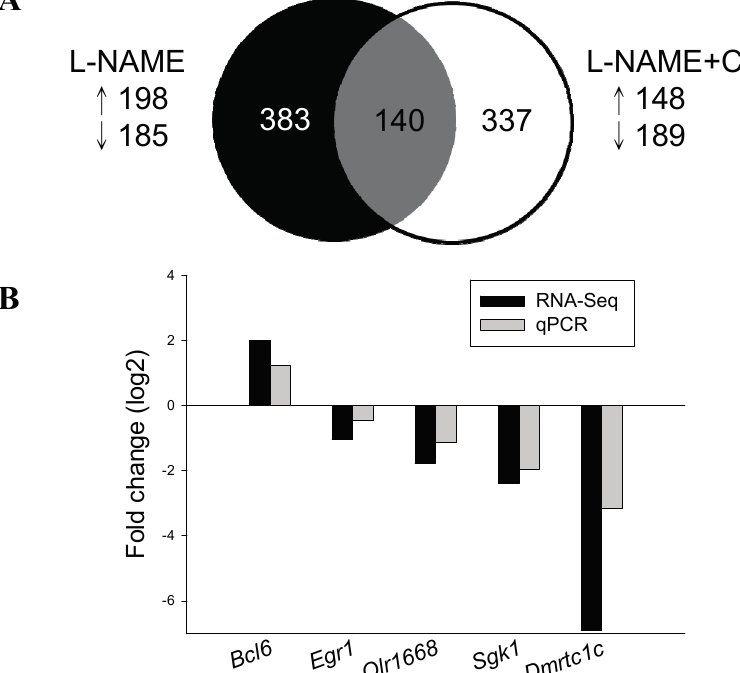
Figure 1. ( A ) Venn diagram depicting unique and shared (over-lapping circles) sets of differentially expressed genes (DEGs) in the kidney between maternal L -NAME therapy (black circle) and L -NAME plus L -citrulline therapy (white circle) at 12 weeks of age; ( B ) Confirmatory analysis of kidney gene expression by qPCR. Individual gene expression was determined by qPCR and expressed as fold change in log base 2 vs. control and graphed alongside fold change derived from RNA-Seq analysis.